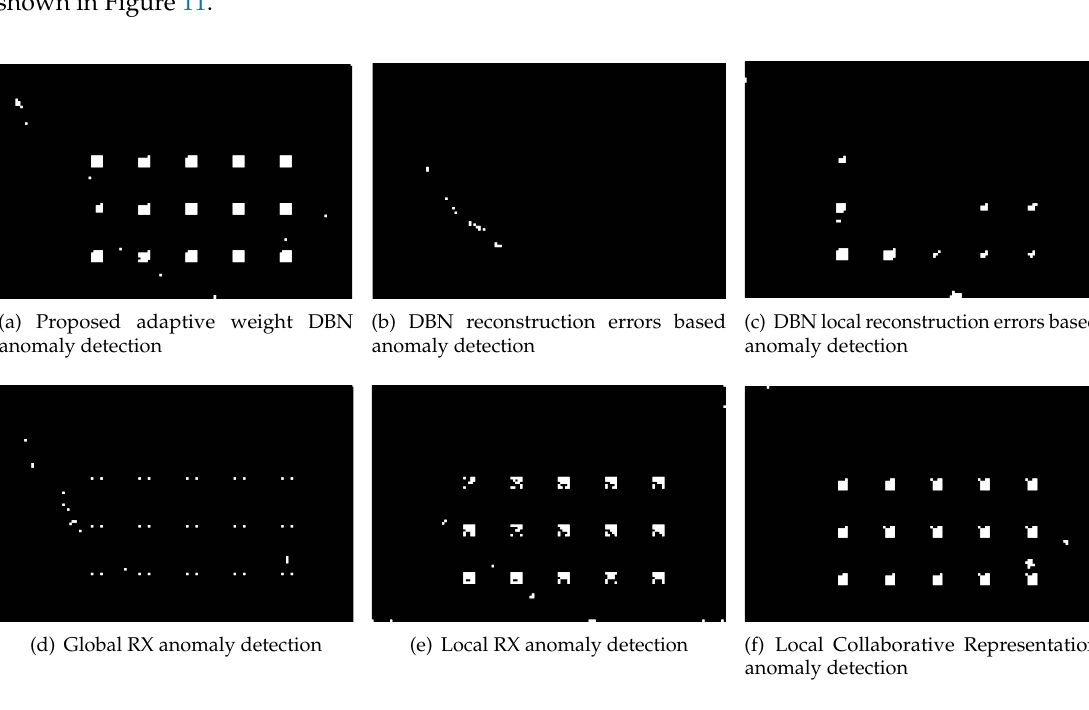
Figure 10. The targets detection result image of Lake Salvador HSI image. Fixed false positive rate for all images in Figure 10 is